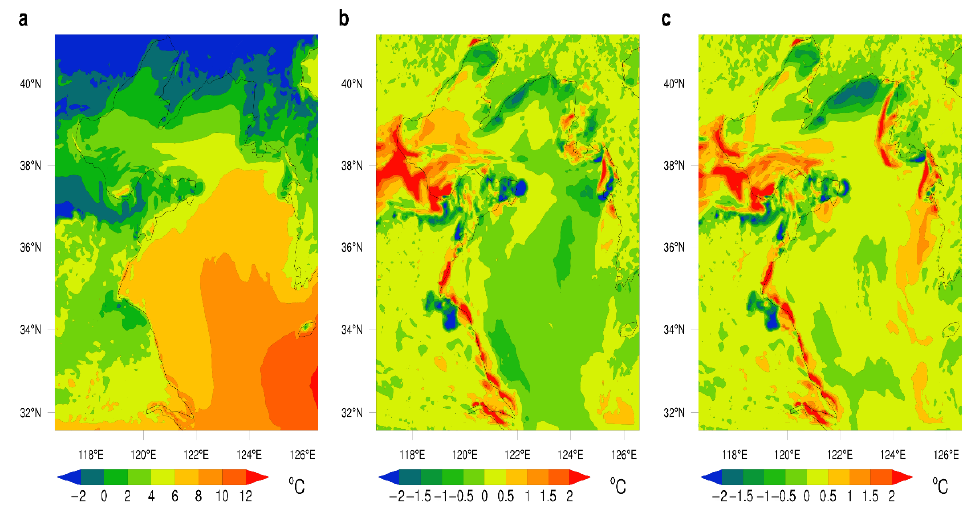
Figure 14. Temperature simulated using the 6h scheme and the temperature difference compared with other schemes at 00:00 UTC on 20 February 2020. ( a ) 2-m temperature of the 6h scheme; ( b ) temperature difference between the 6h scheme and daily scheme; ( c ) temperature difference between the 6h scheme and FNL scheme.